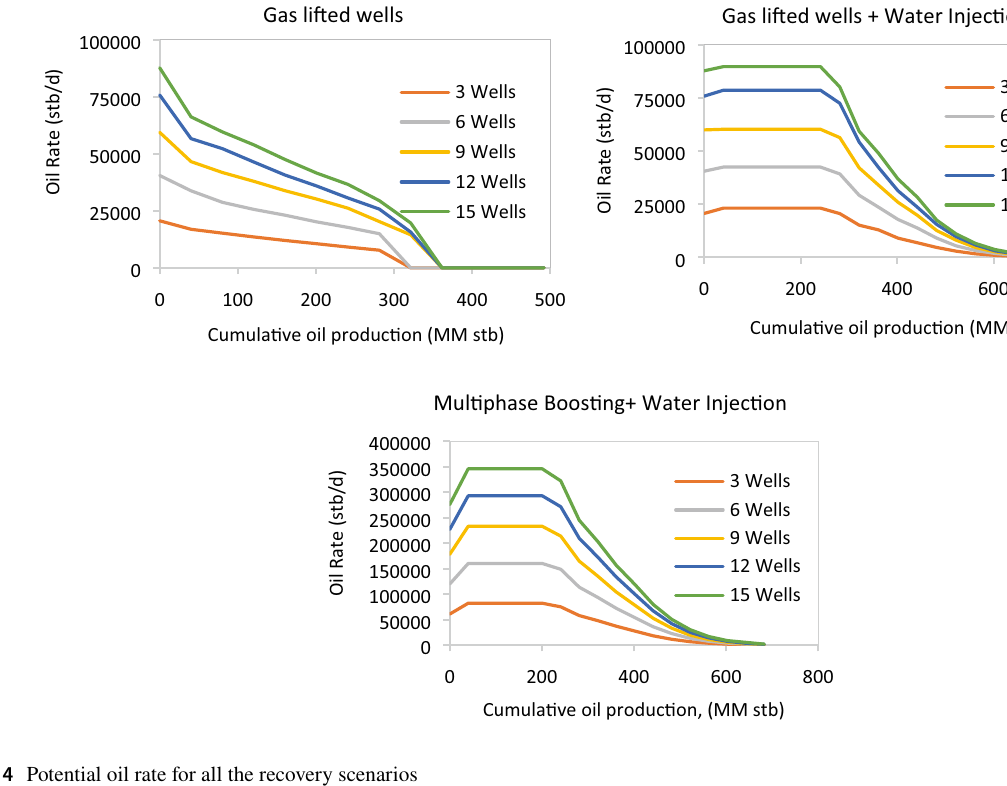
Fig. 14 Potential oil rate for all the recovery scenarios